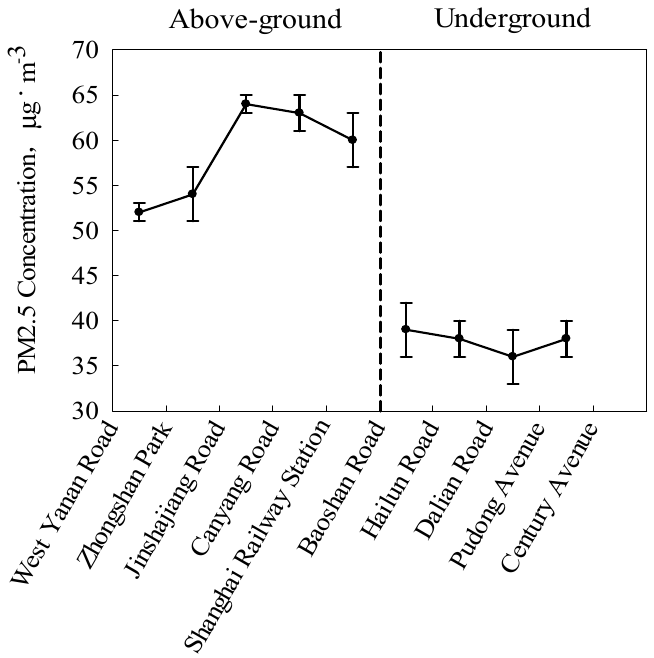
Figure 4. Average PM2.5 concentrations in metro carriages under above-ground and underground conditions. The error bar indicates the standard deviation.